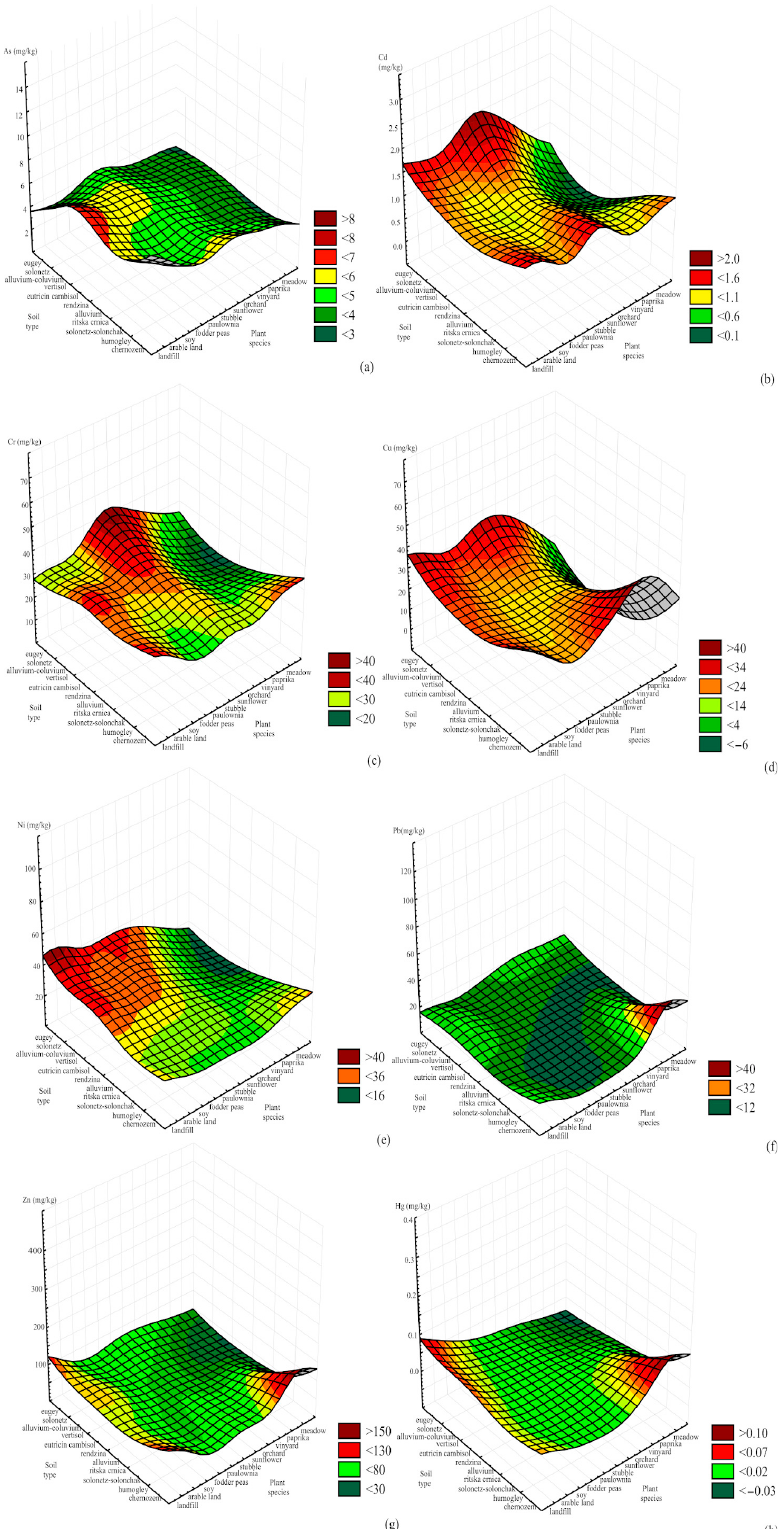
Figure 5. Influence of input variables on HM concentrations: ( a ) As, ( b ) Cd, ( c ) Cr, ( d ) Cu, ( e ) Ni, ( f ) Pb, ( g ) Zn and ( h ) Hg.